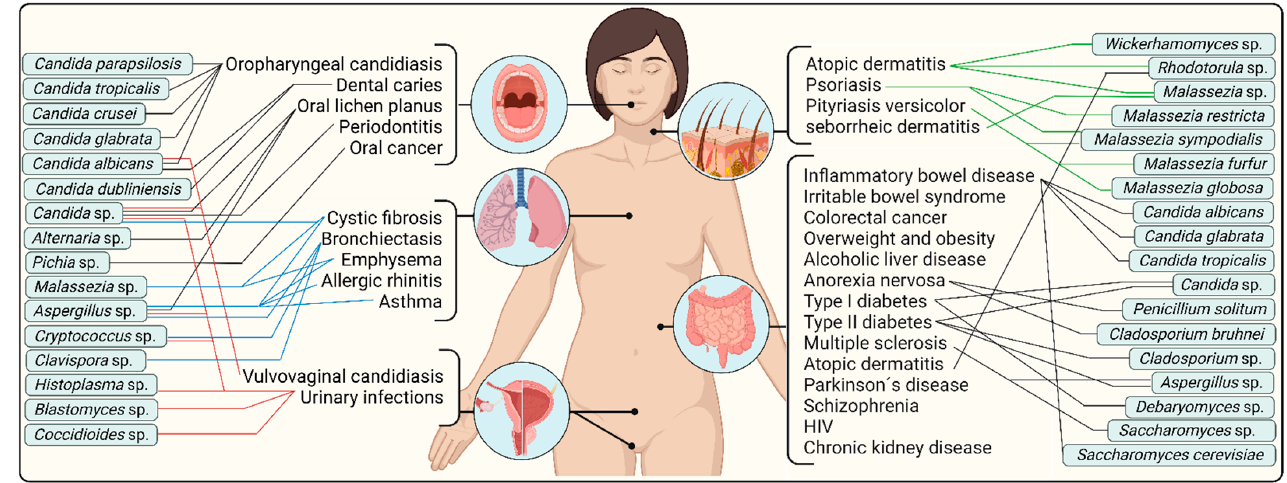
Figure 2. The summary of diseases in which gut mycobiome dysbiosis at various body sites could play a role. Fungal taxa potentially involved in the pathogenesis are included, specifically oral cavity mycobiome dysbiosis (black lines on the left), respiratory tract mycobiome dysbiosis (blue lines on the left), genitourinary tract mycobiome dysbiosis (red lines on the left), skin mycobiome dysbiosis (green lines on the right) and gastrointestinal mycobiome dysbiosis (black lines on the right). Created with BioRender.com (accessed on 28 Septemebr